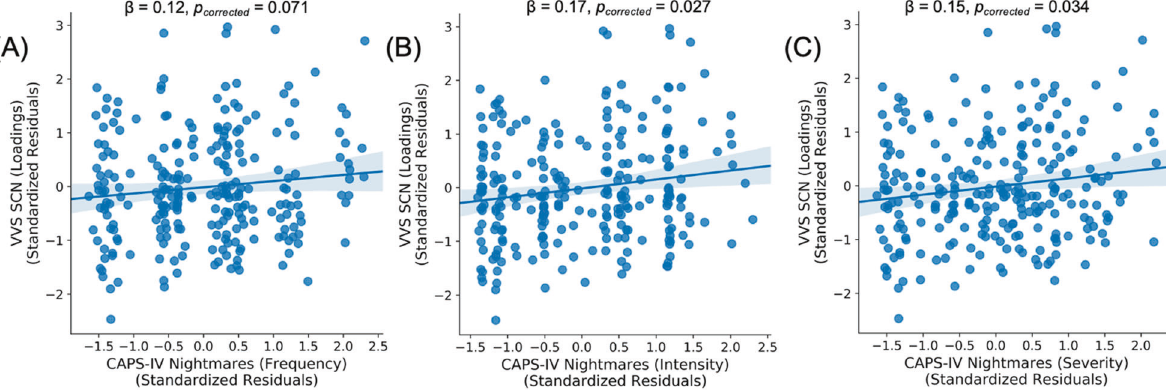
Fig. 2 Ventral visual stream structural covariance strength is related to nightmare symptoms. Individual participant loadings on the VVS SCN identi fi ed through linked independent components analysis (LICA) varied positively with participants ’ nightmare frequency ( A ), intensity ( B ), and severity ( C ) scores at 2 weeks post trauma. Scatter plots are partial plots where dots represent the standardized residuals of individual participant loadings and nightmare index scores. Lines represent the linear line of best fi t and the shaded bar represents the 95% con fi dence